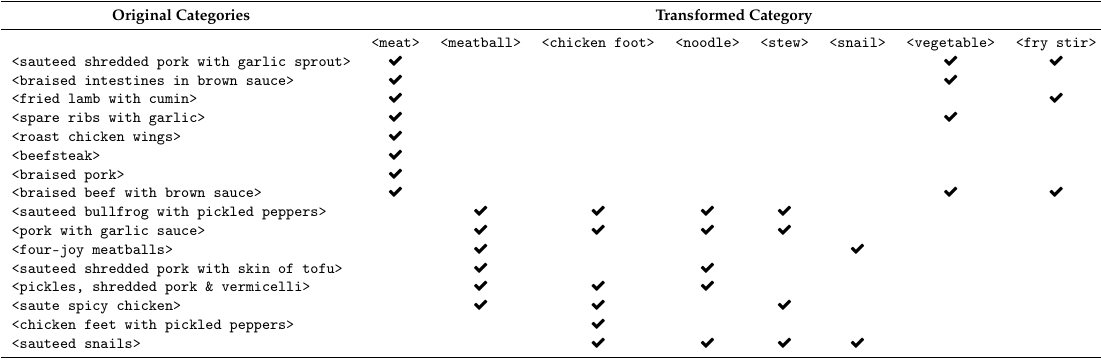
Table 5. Transformation of subset D (cid:48) labels into transformed labels for ENG demography.